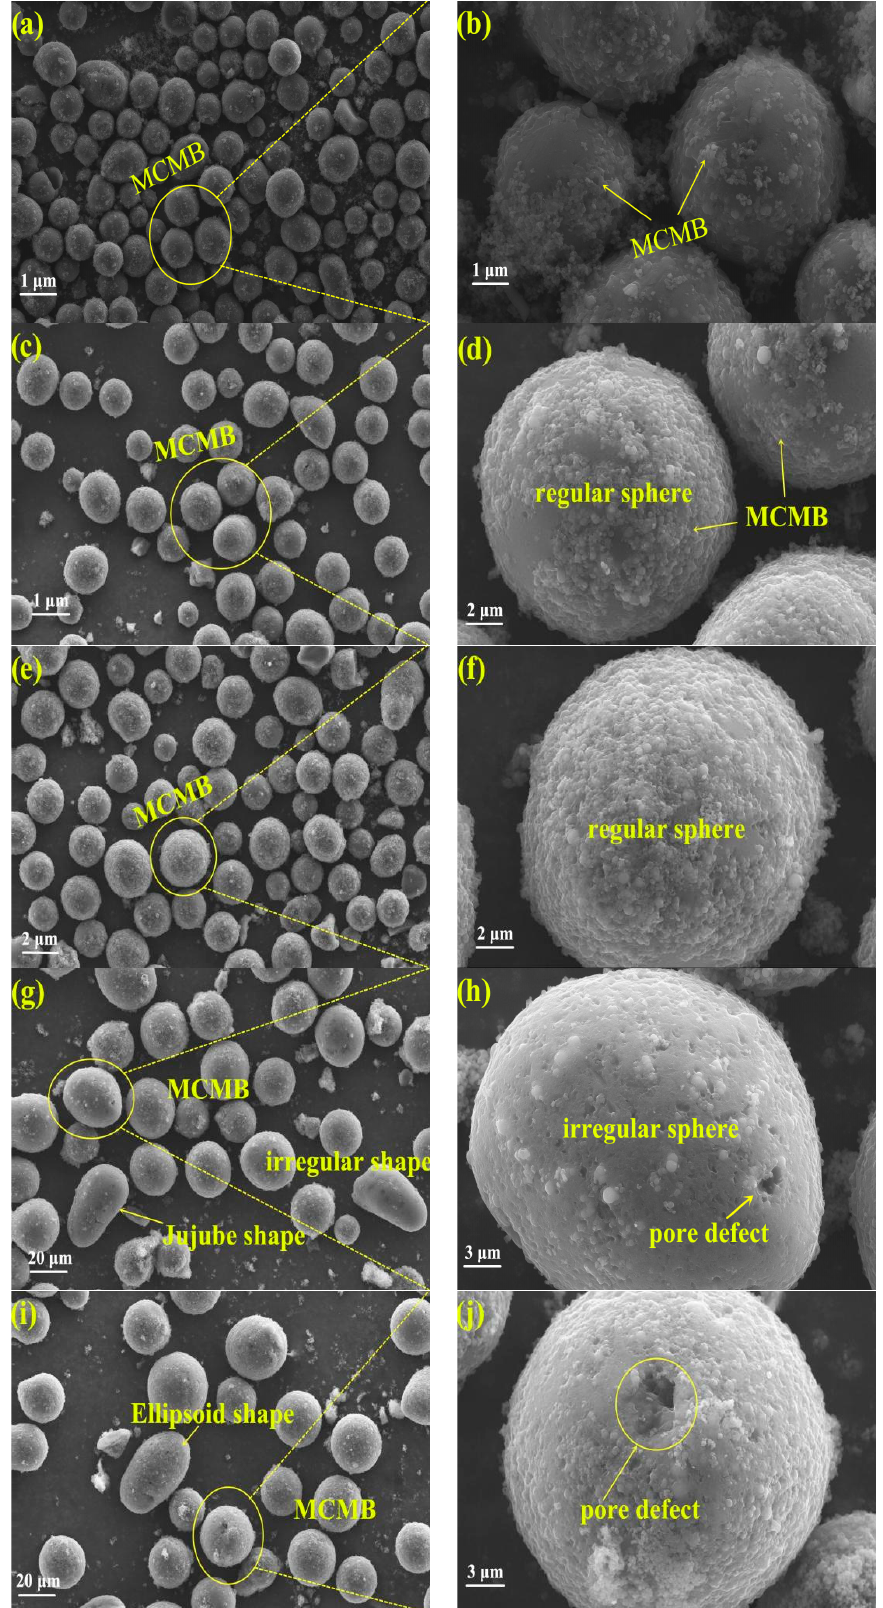
Figure 5. The surface morphology of MCMBs for: ( a , b ) MCMB-0%, ( c , d ) MCMB-1.5%, ( e , f ) MCMB- 3%, ( g , h ) MCMB-5%, ( i , j ) for